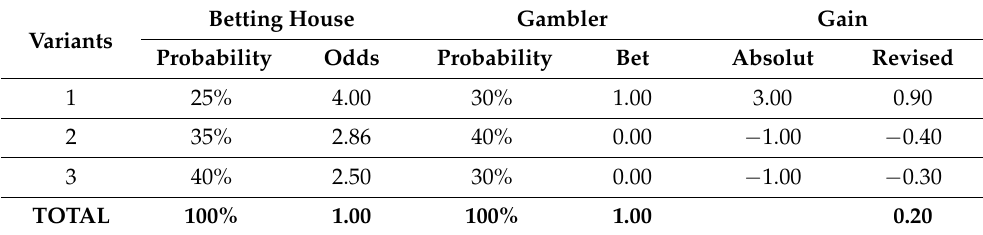
Table 4. How to invest if the broker’s quotation is considered wrong.